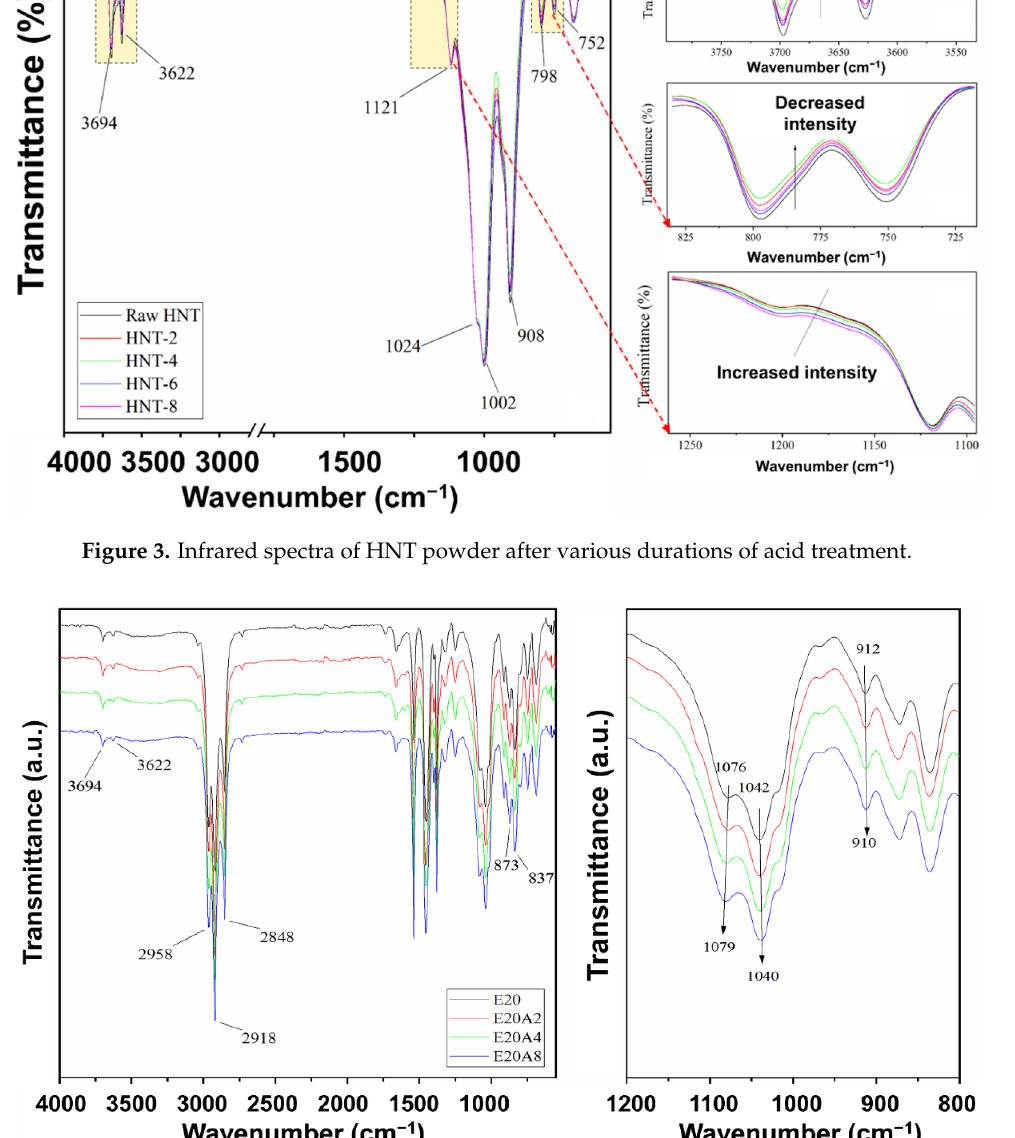
Figure 3. Infrared spectra of HNT powder after various durations of acid treatment.